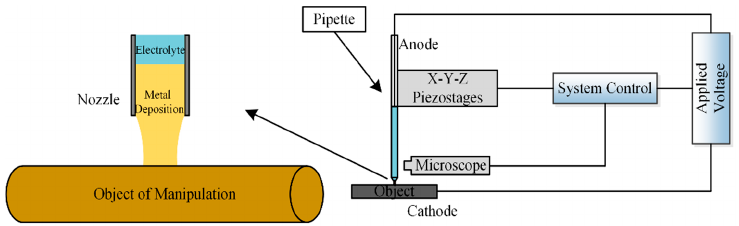
Figure 1. Diagram of the proposed manipulation method.